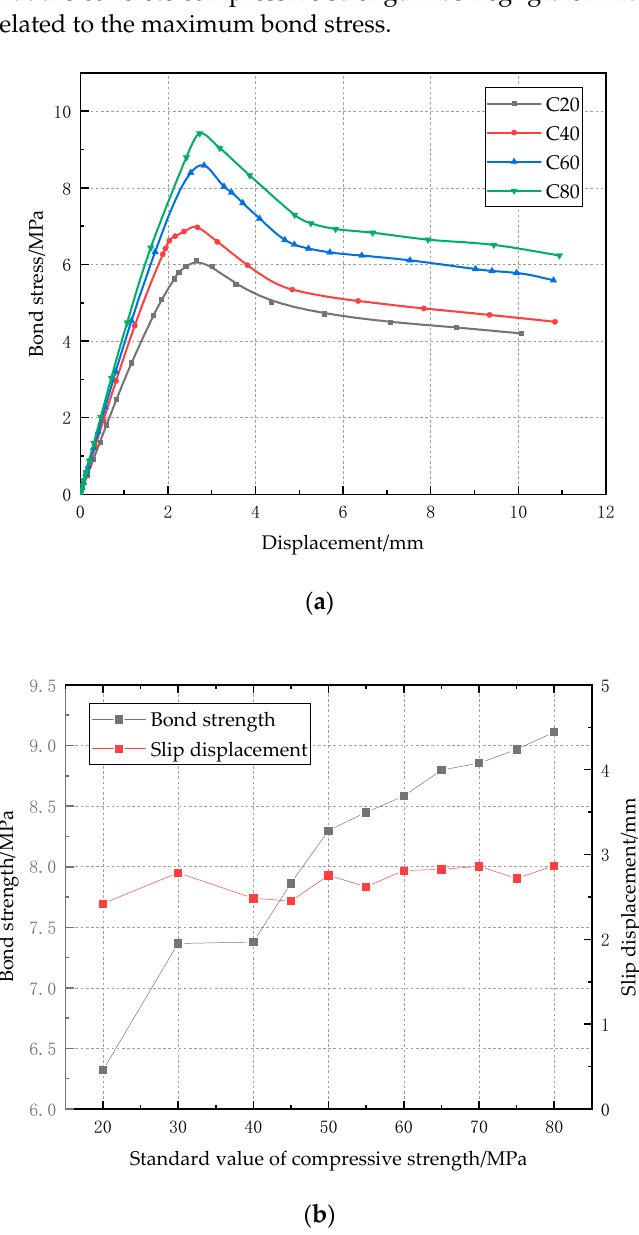
Figure 10. Effect of concrete compressive strength on bond strength: ( a ) bond-clip curves; ( b ) rela- tionship between bond strength/slip displacement and concrete strength.